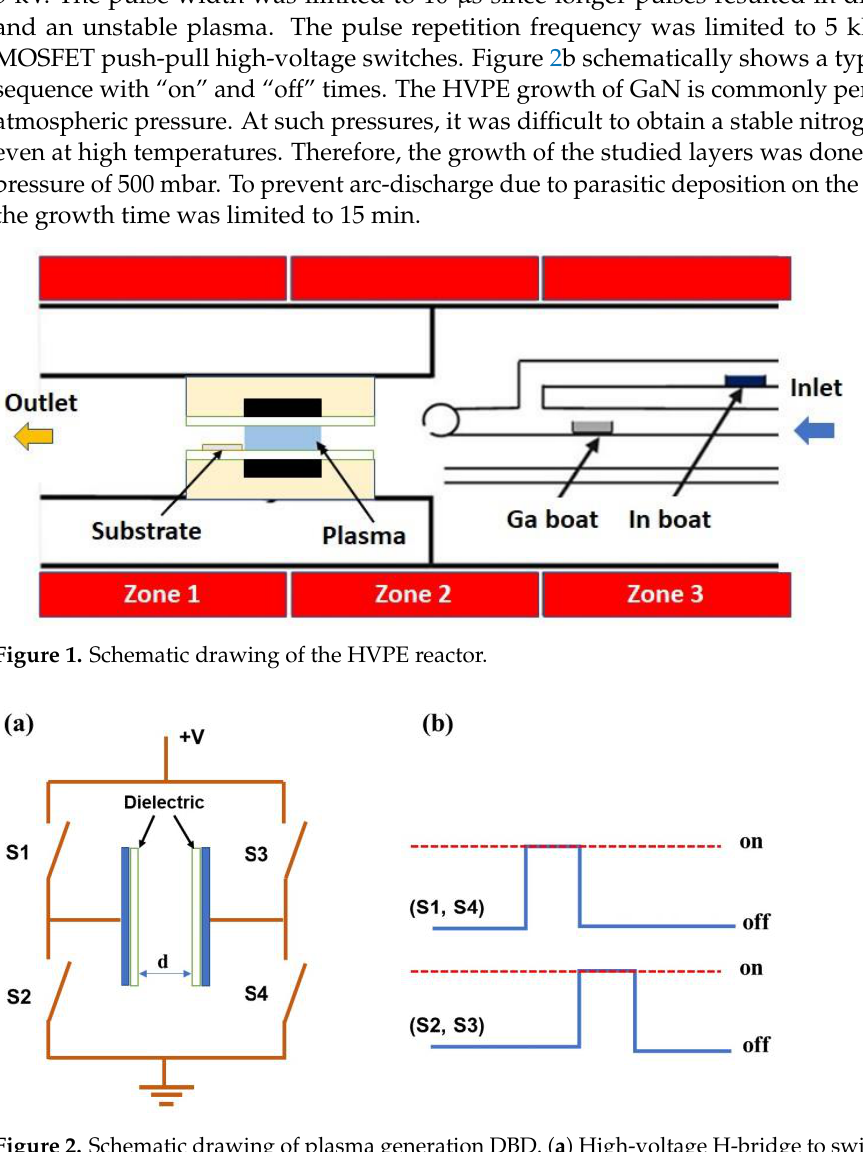
Figure 1. Schematic drawing of the HVPE reactor.